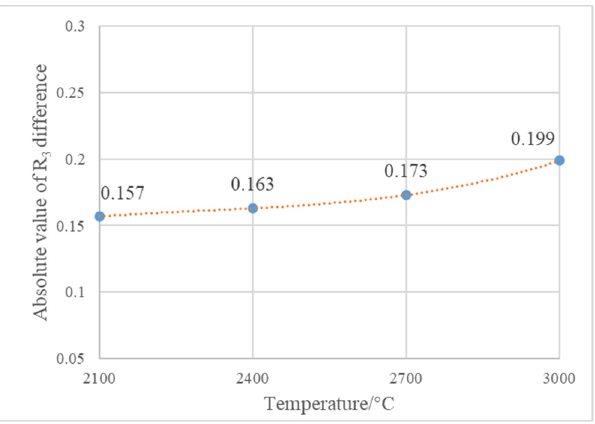
Figure 10. Differences in R 3 of G and GS sample evolution characteristics with temperature.